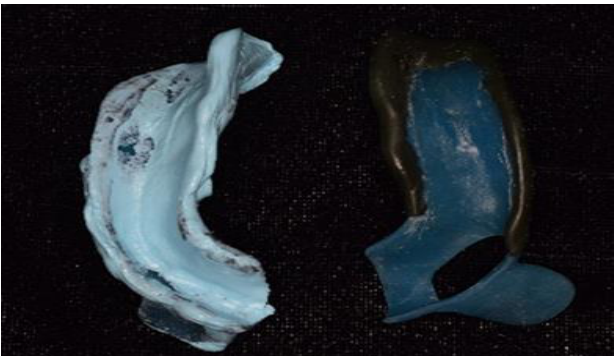
Fig. 4B. Mandibular taking impression steps.